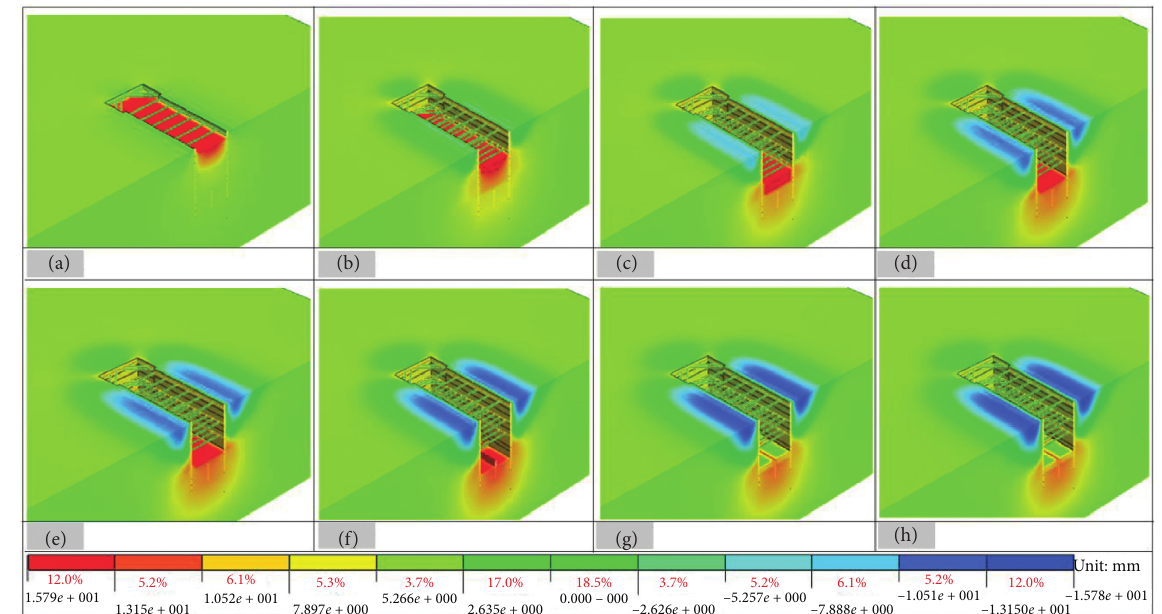
Figure 6: The contour of settlement with 3D-analysis for YDM project. (a) Step 1, (b) step 2, (c) step 3, (d) step 4, (e) step 5, (f) step 6, (g) step 7, and (h) step